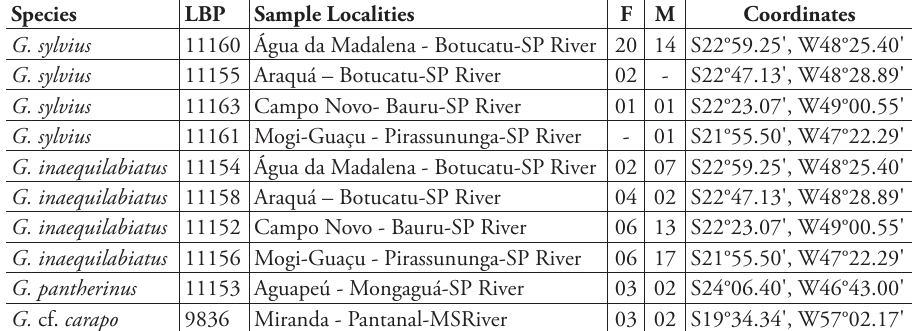
Table 1. Specimens of Gymnotus analyzed. LBP – deposit voucher number at the fish collection of the Laboratório de Biologia e Genética de Peixes, Instituto de Biociências de Botucatu, UNESP. F –